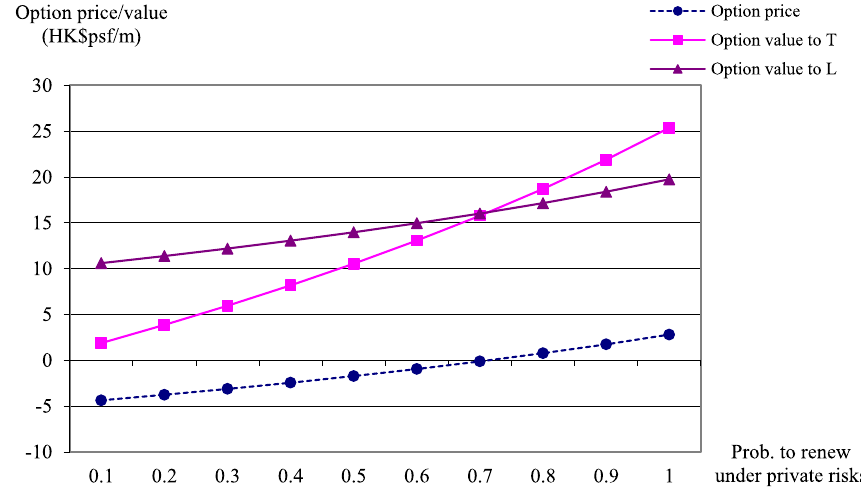
Fig. 8 Effect of probability of renewal under private risks on option